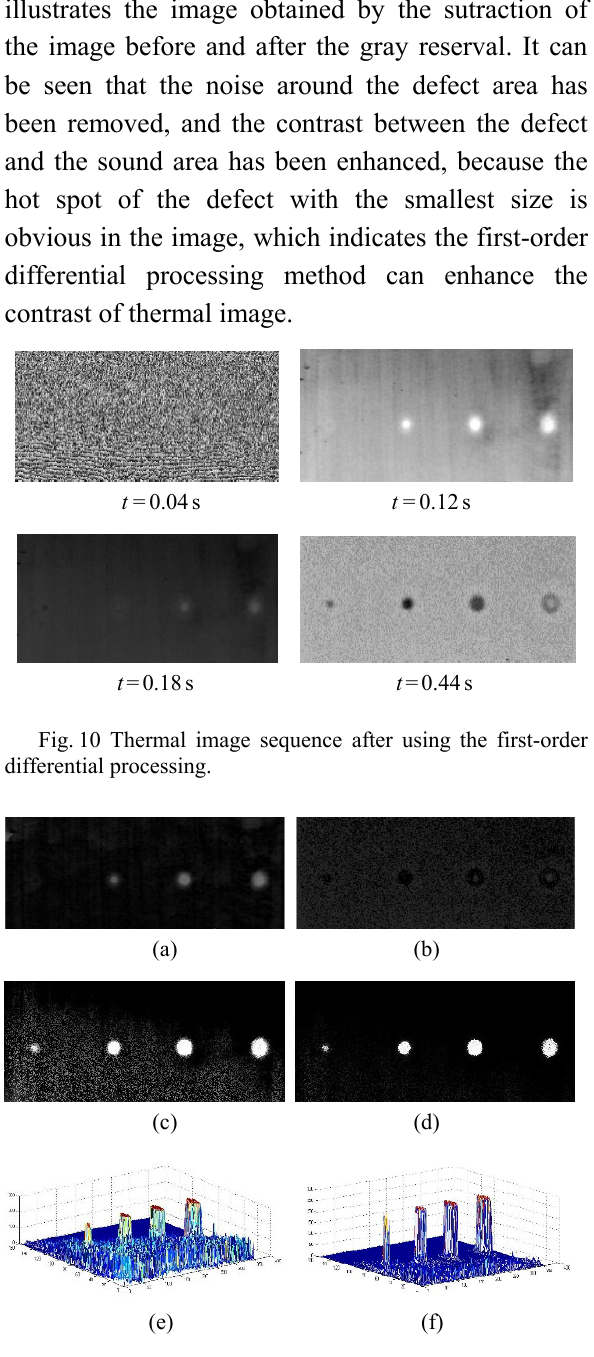
Fig. 11 Results of the subtraction process using the first-order differential processing: (a) subtract backgroud before the gray reversal, (b) subtract background after the gray reversal, (c) images in (a) subtract image (b), (d) denoise, (e) results of the three dimensional image of image (c), (f) results of the three dimensional image of (d).